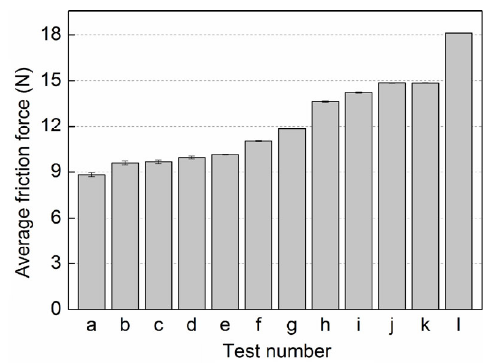
Fig. 6 Average friction force of tests. Table 2 SD of tests (a)-(l) of Figs. 4 and 5. Test